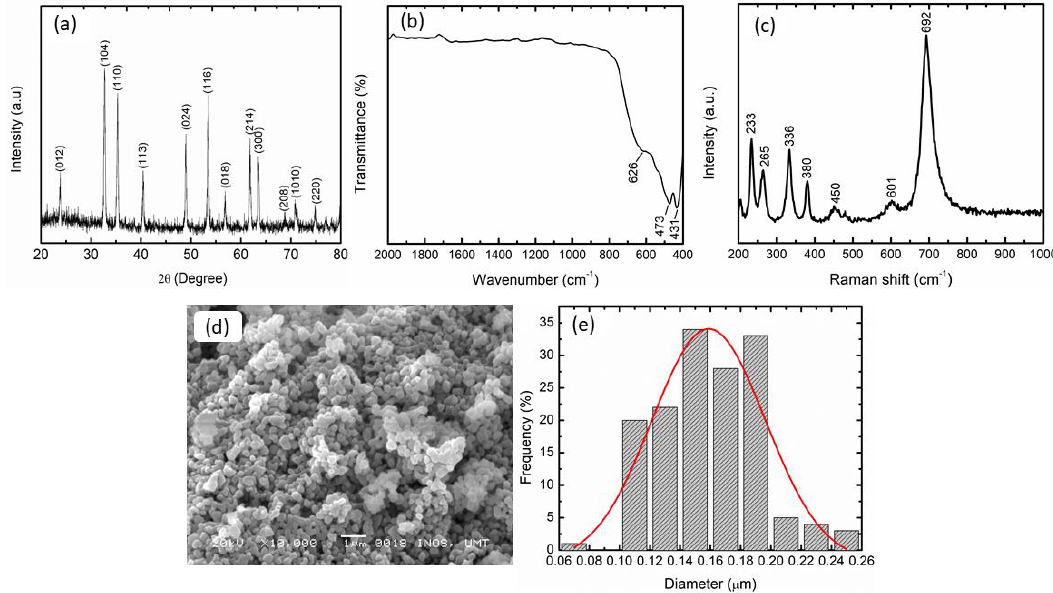
Figure 1. ( a ) XRD profile, ( b ) FTIR spectra, ( c ) Raman spectra, ( d ) SEM image, and ( e ) particle size distribution of as-synthesized CoTiO 3 .